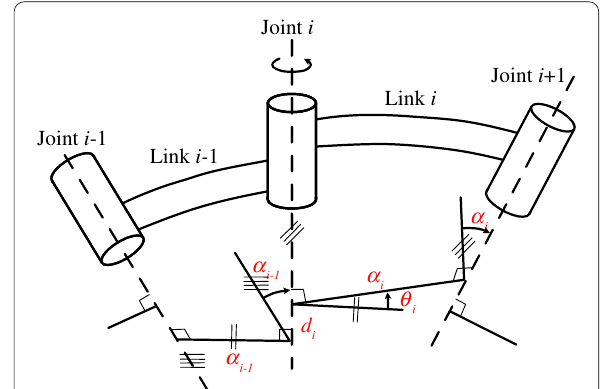
Fig. 5 Denavit-Hartenberg parameters